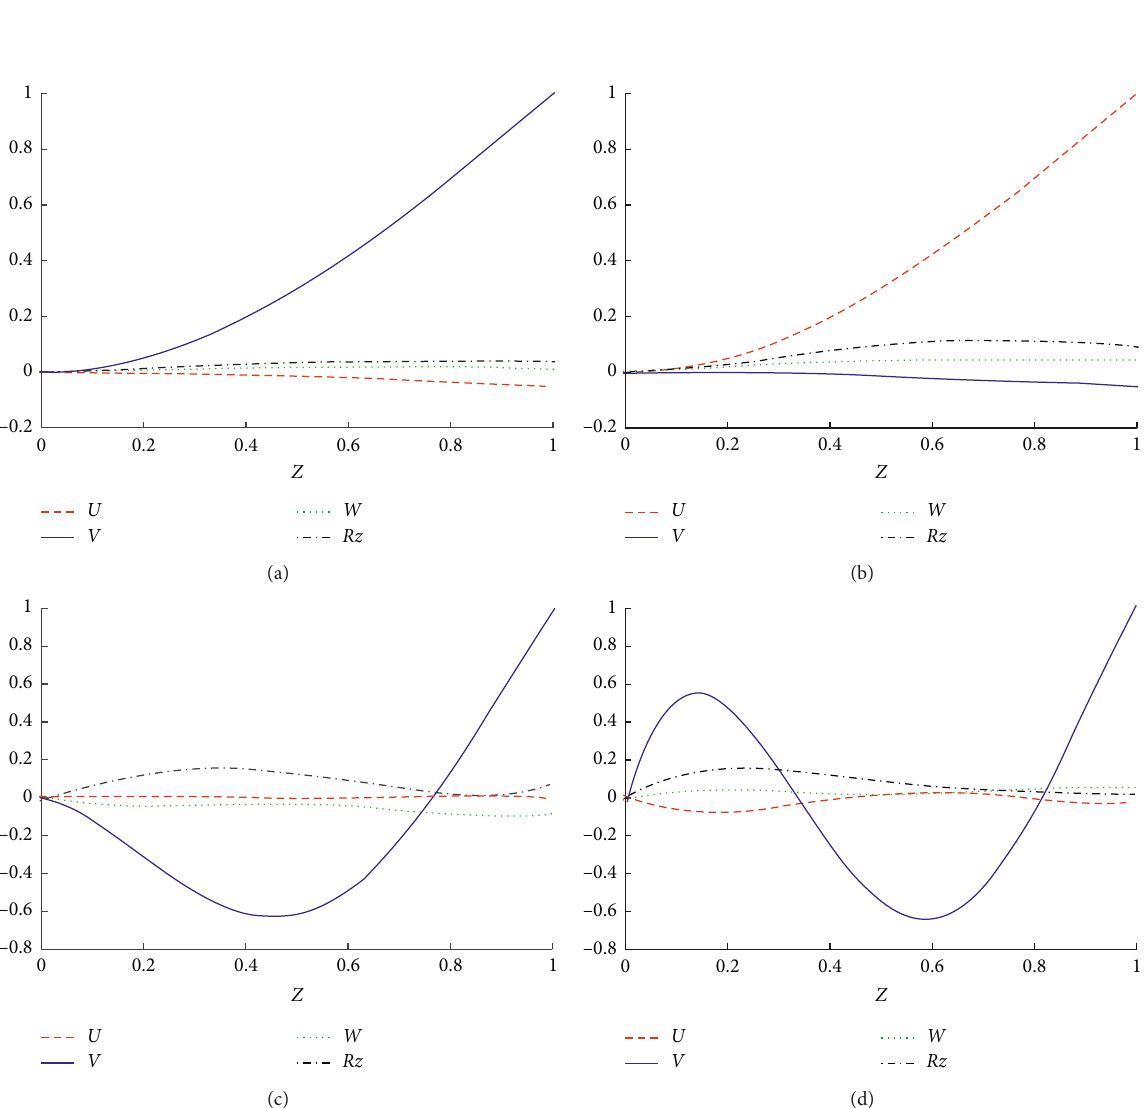
Figure 6: The first four mode shapes of the tapered wind turbine blade using SFEM. (a) First mode shape. (b) Second mode shape. (c) Third mode shape. (d) Fourth mode